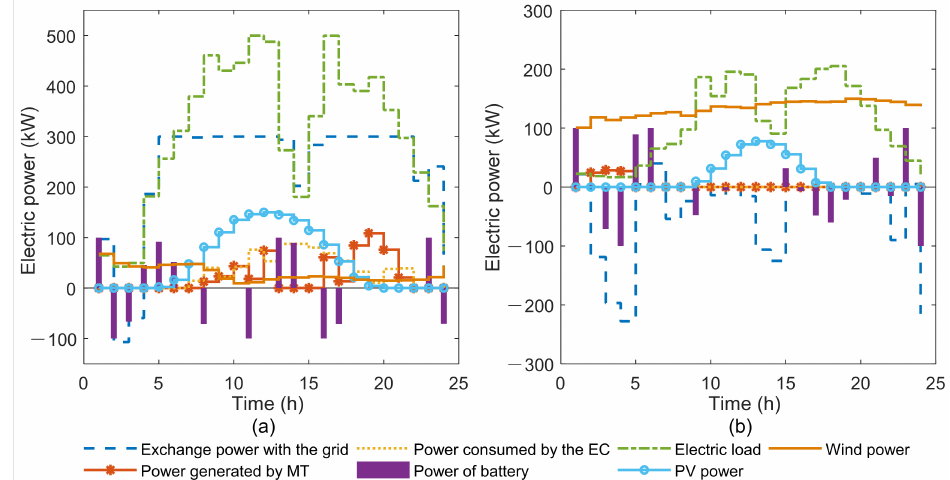
Figure 9. Optimal operation results of electric power ( a ) summer ( b ) winter.